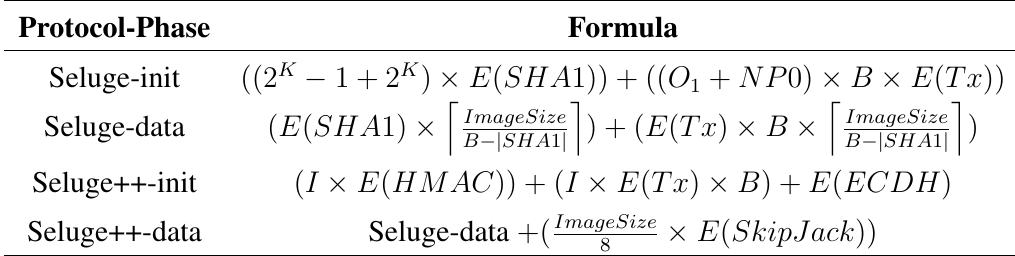
Table 11. The formulas used for the energy cost calculation of Seluge and